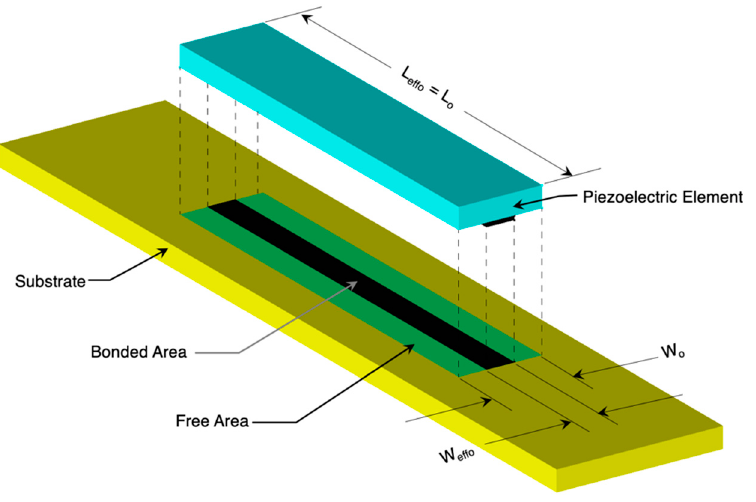
Figure 4. Basic definitions of lateral attachment geometries for DAP elements.